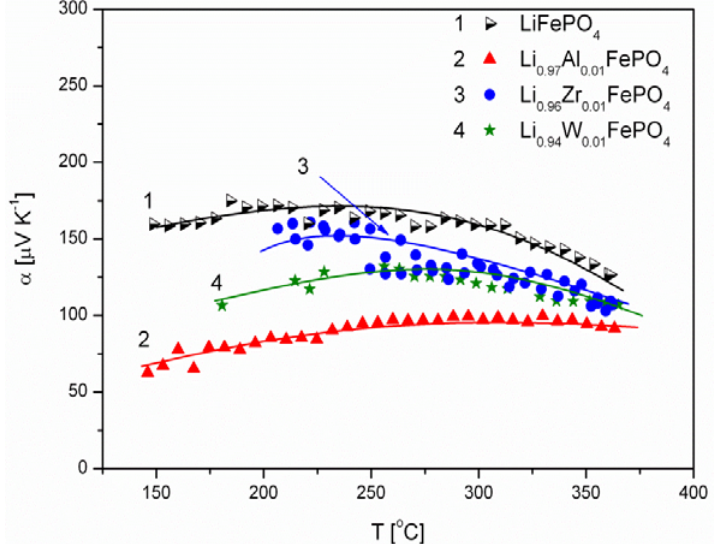
Figure 11. Temperature dependence of thermoelectric power of Li-site substituted phosphoolivines with x = 0.01 mol mol − 1